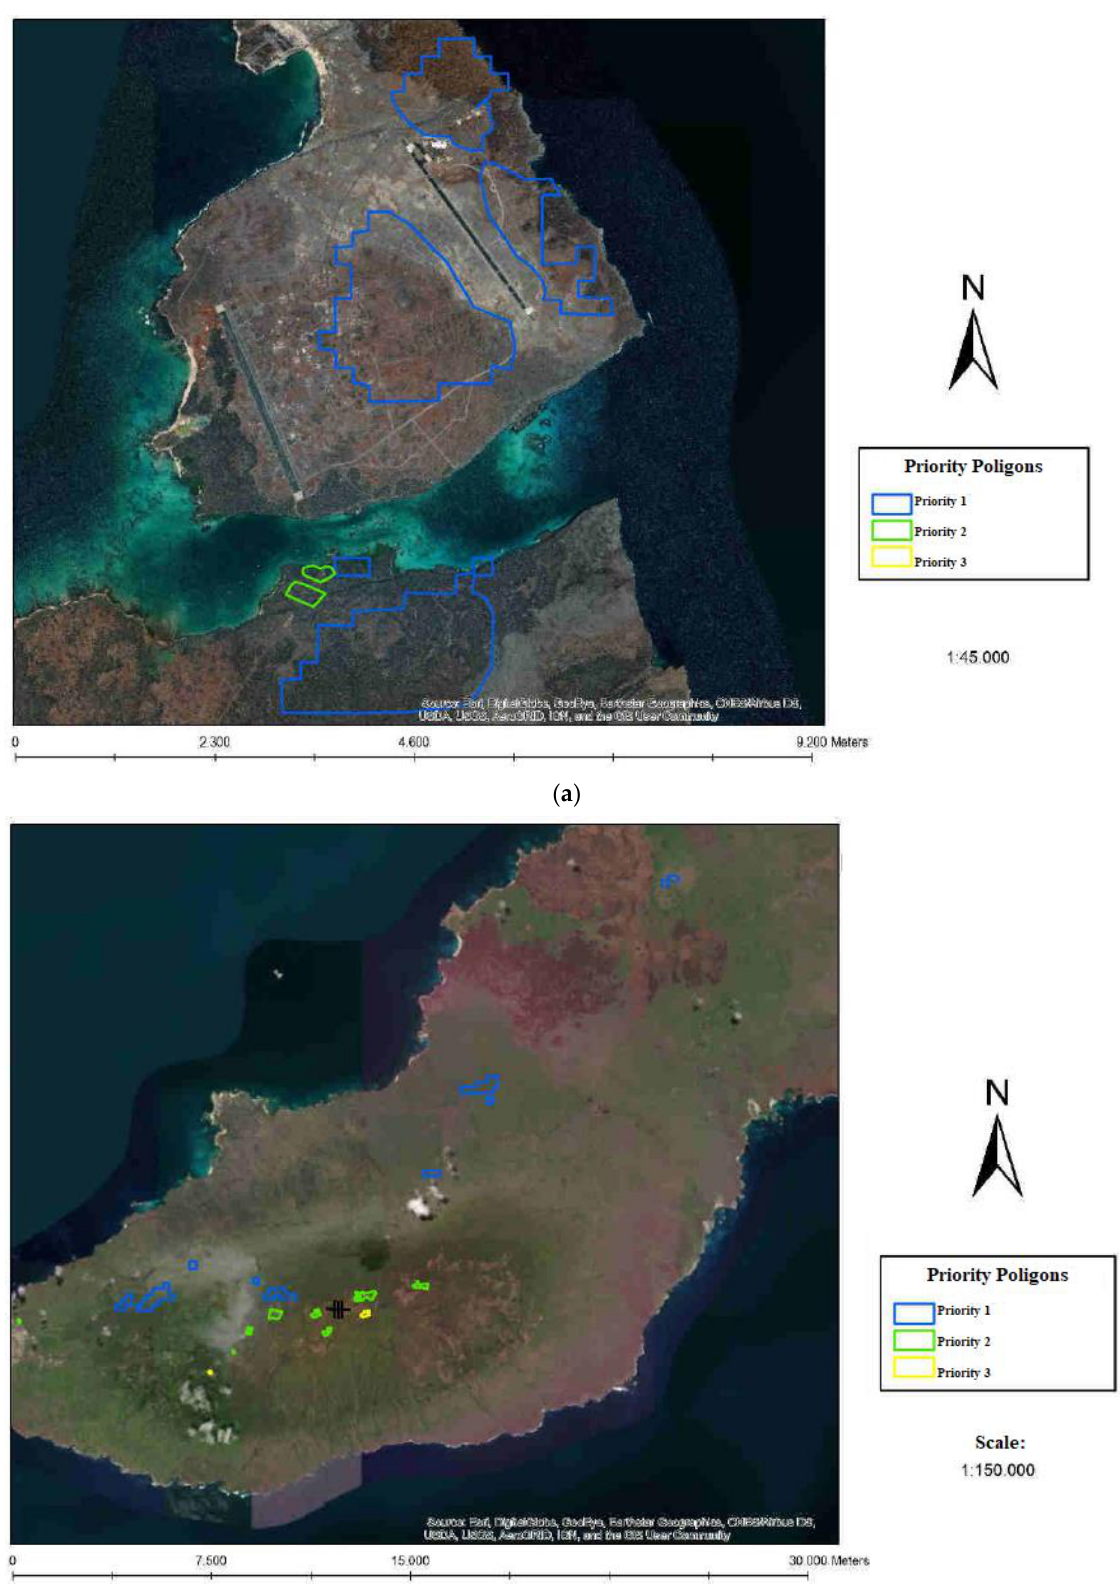
Figure 9. Priority Polygons for wind farms. ( a ) results for Baltra and Santa Cruz; ( b ) Results for San